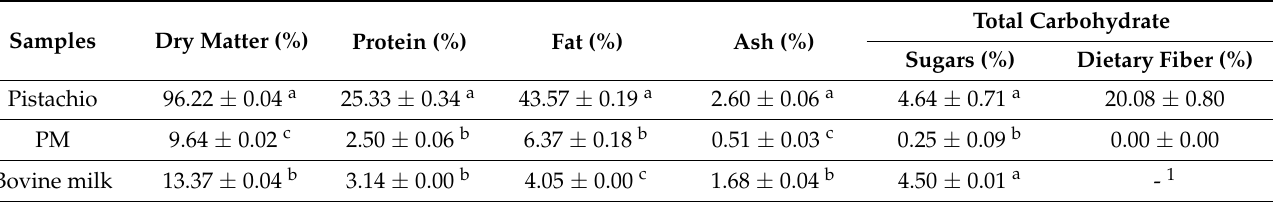
Table 2. Proximate composition of pistachio, PM, and bovine milk.